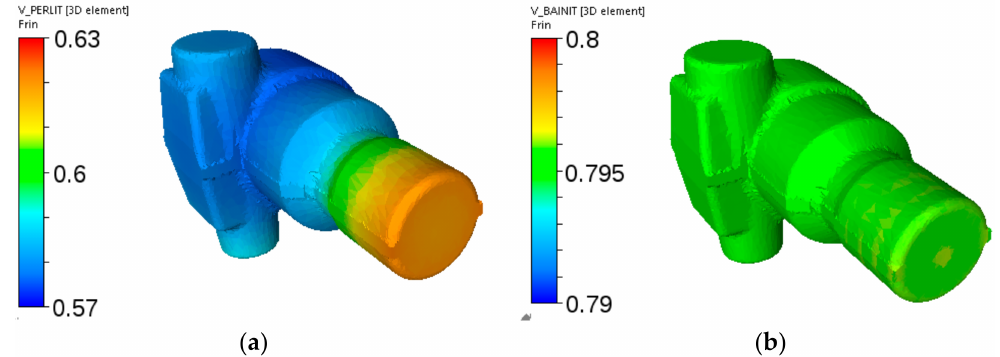
Figure 19. Cooling of the adapter from steel A—calculated distributions of the pearlite volume fraction after holding at 560 ◦ C for 1 h ( a ) and of the bainite volume fraction after holding at 520 ◦ C for 1 h ( b